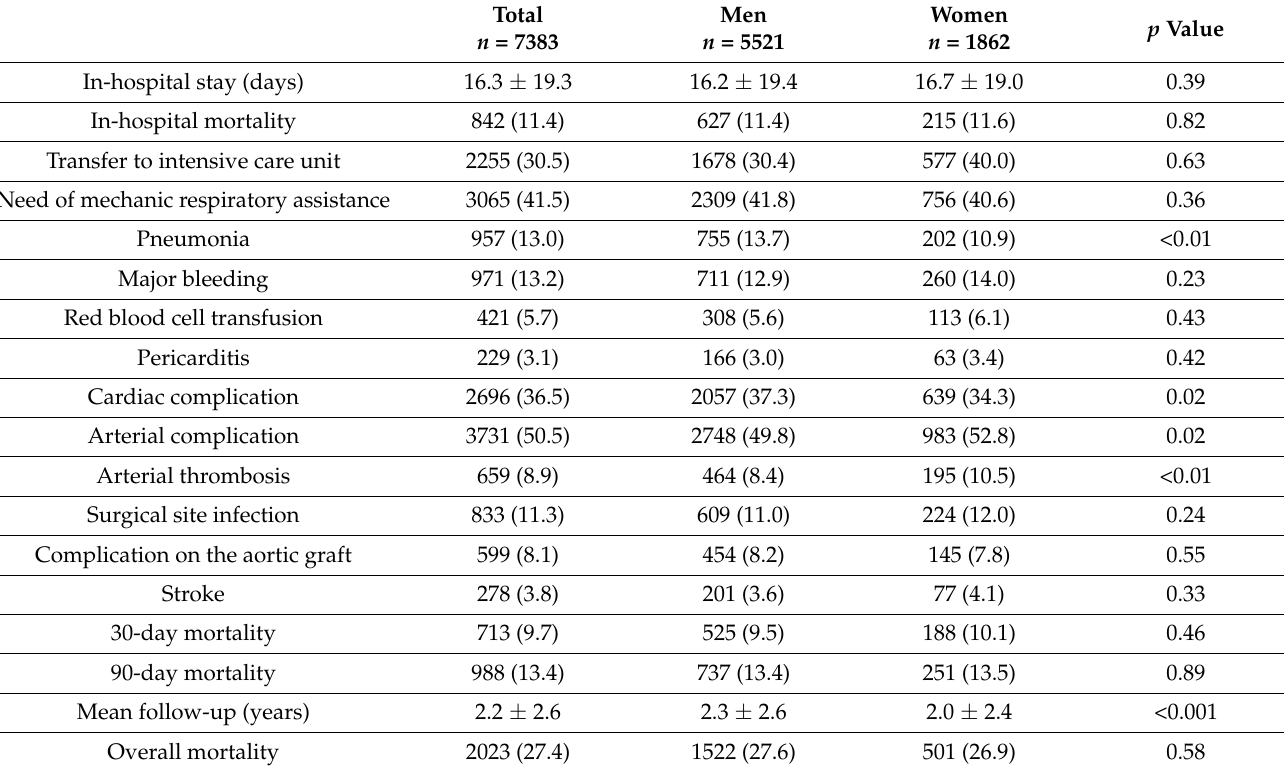
Table 2. Outcomes of patients who underwent endovascular thoracic aortic aneurysm repair (TEVAR). Total n = 7383